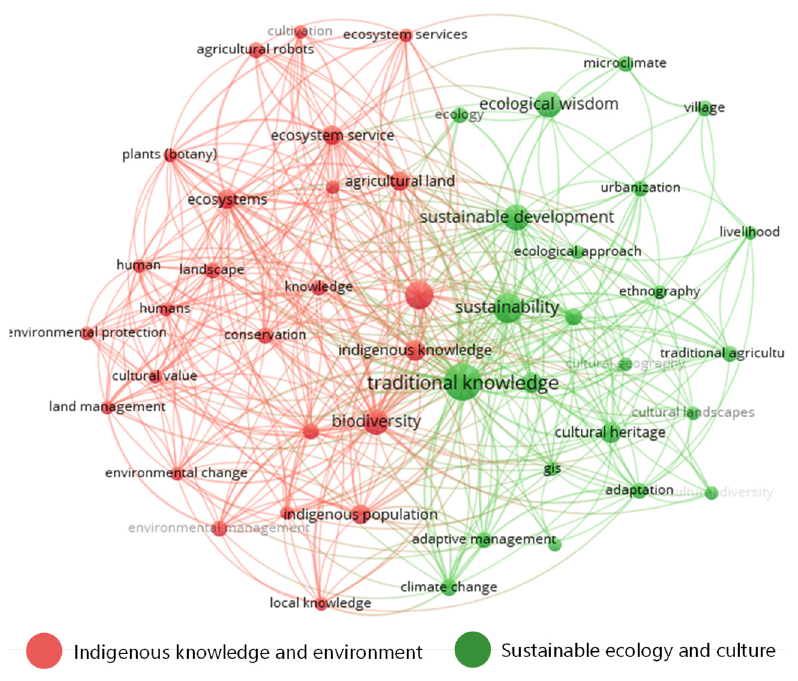
Figure 2. Keywords mapping. Table 2. The keywords of each cluster.